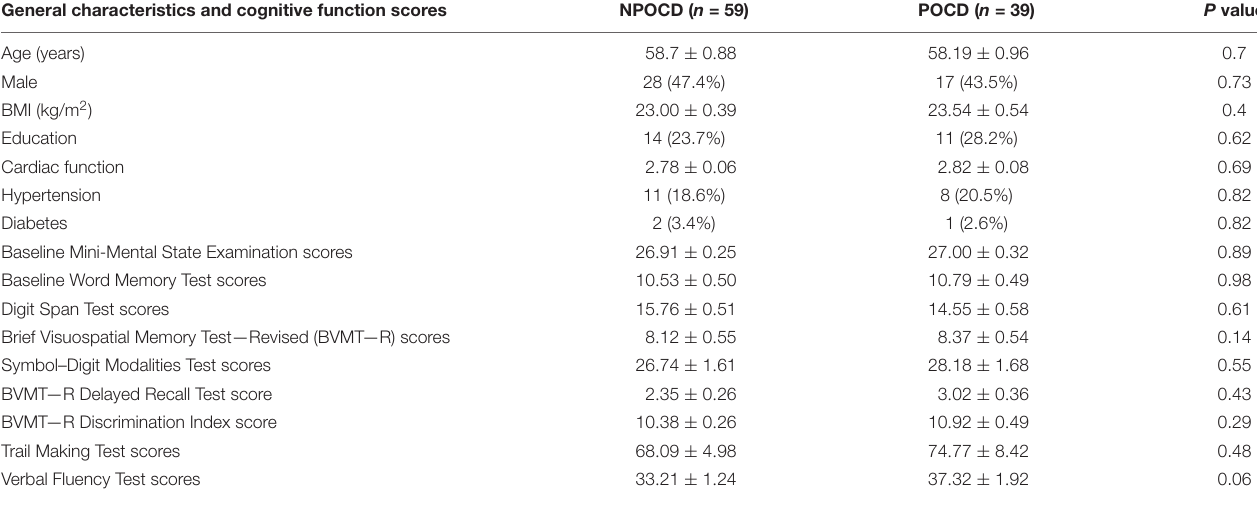
TABLE 2 | General characteristics and cognitive functions of the participants from the postoperative cognitive dysfunction (POCD) and non-POCD groups at baseline. General characteristics and cognitive function scores NPOCD ( n =